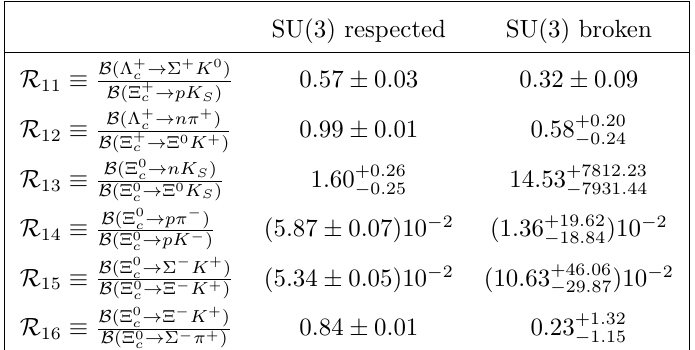
Table 7 . Predictions of branching fraction ratios between some special modes in both scenarios on SU (3) flavor